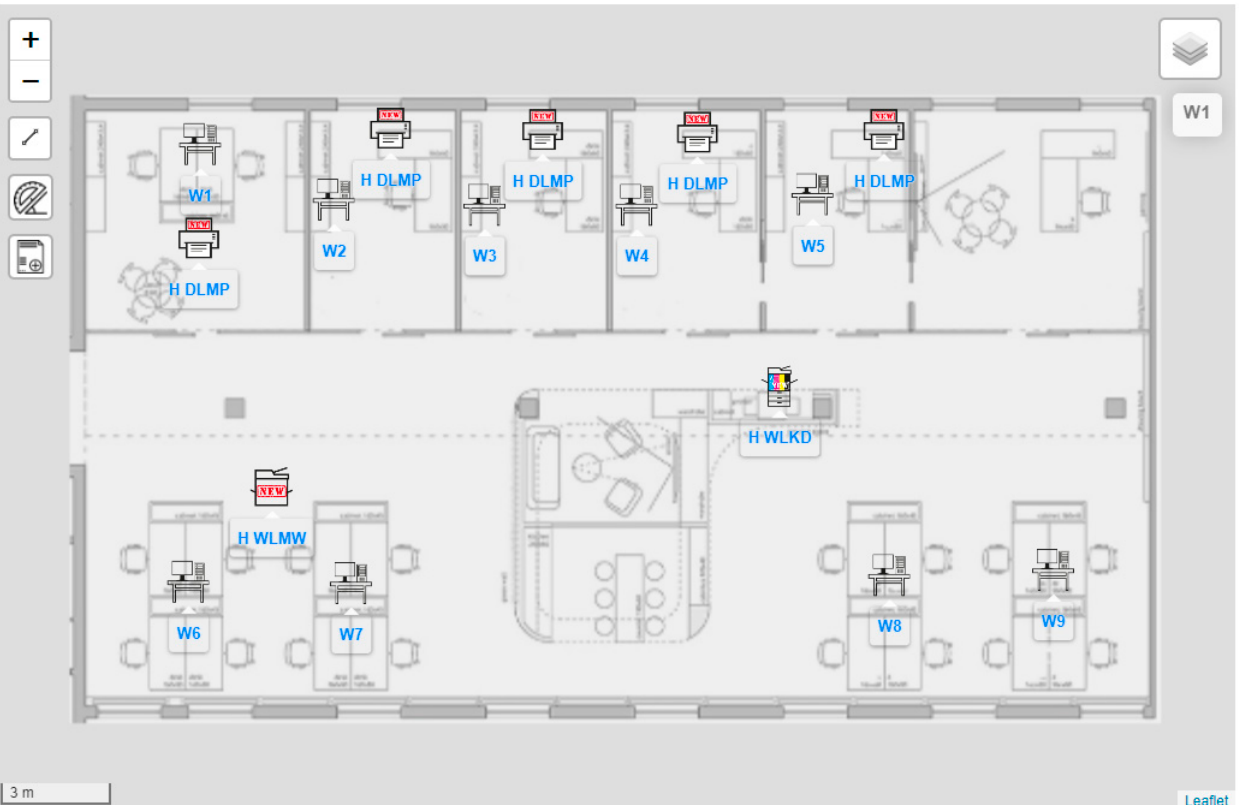
Figure 7. Reference (REF) scenario results—assignment of printing devices to places and workstations.